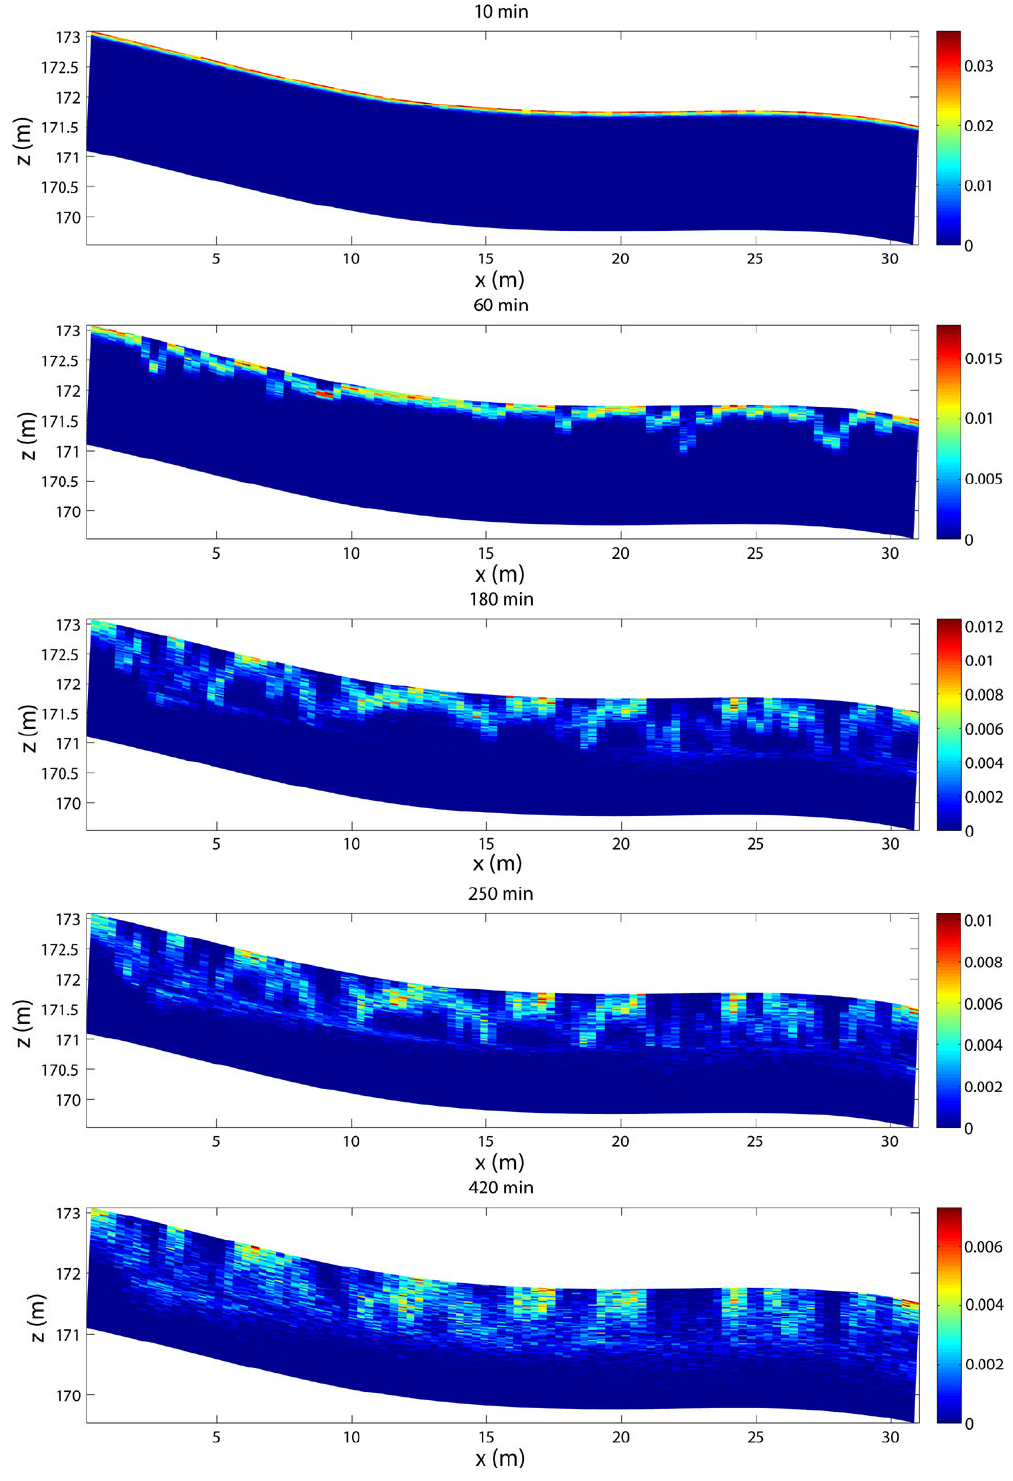
Fig. 6. Bromide concentrations (g kg − 1 dry soil) in the model domain, and the development over time. Please note that the concentrations are plotted for a 30 m wide hillslope, and that the colour scale changes over